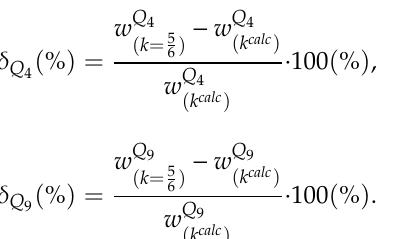
Figure 12. Porosity distribution models M2 and M3: evolution of the shear correction factor.